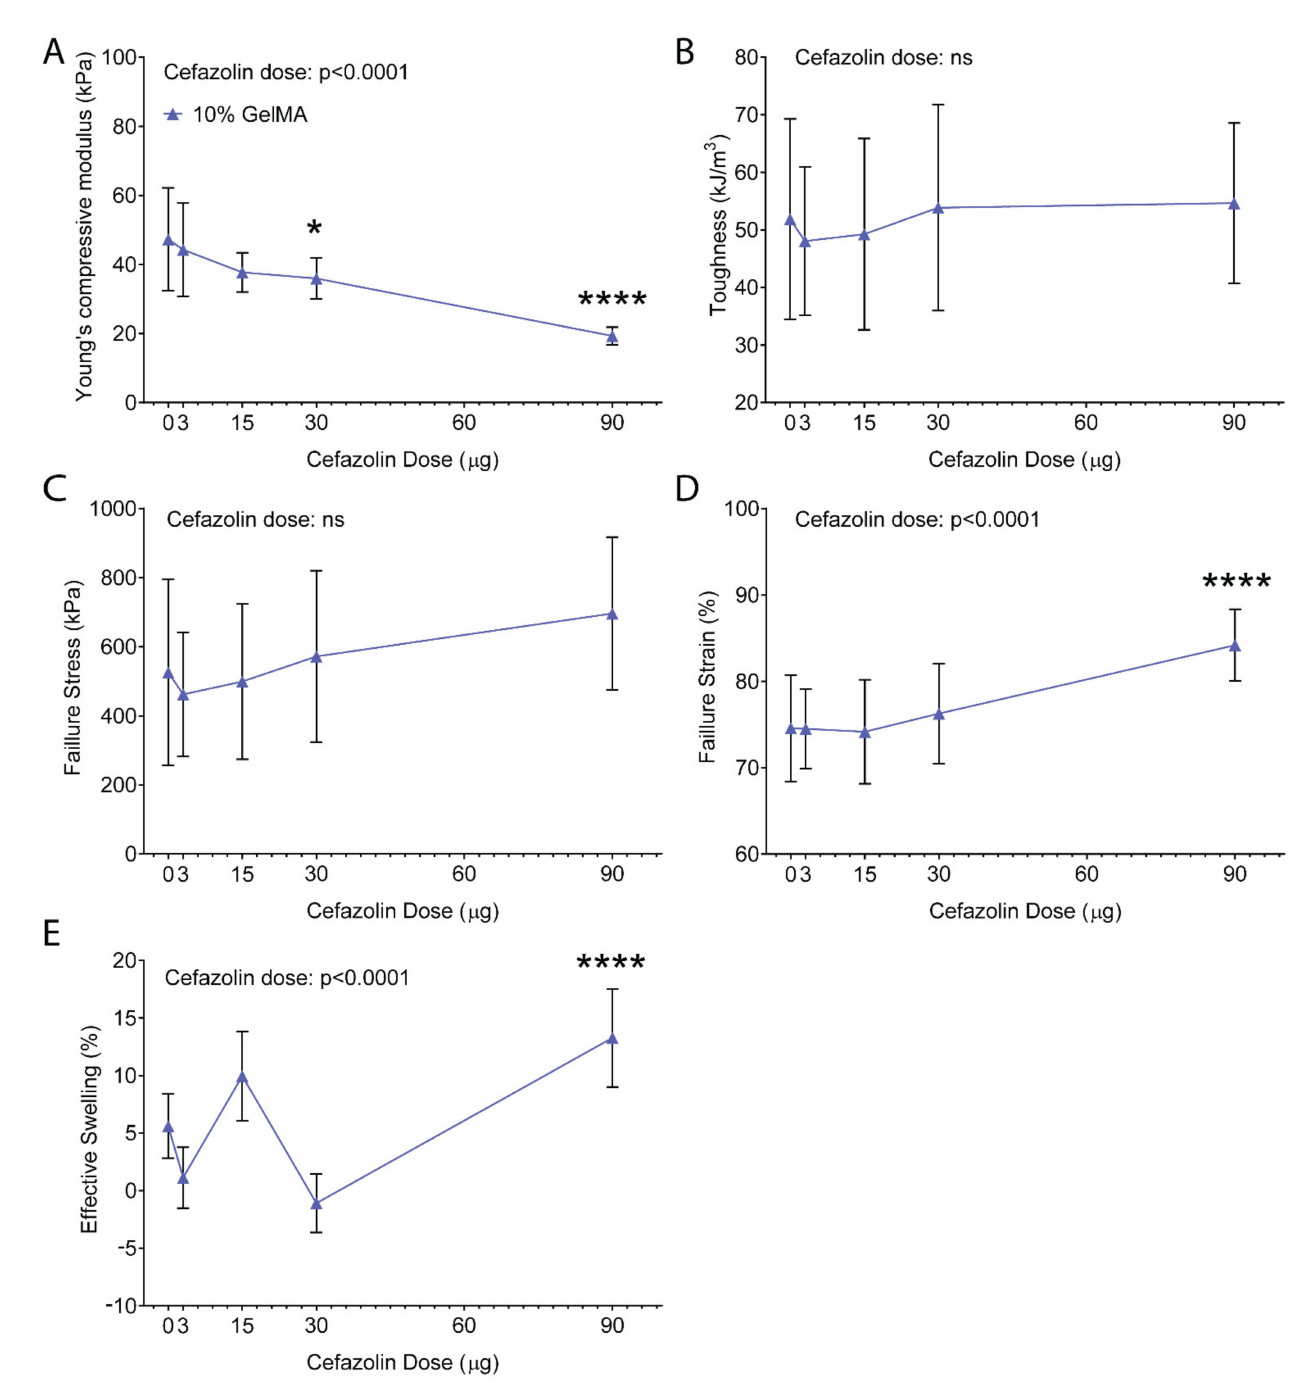
Figure 5. Compressive properties of GelMA-DDS hydrogels at 10% GelMA for cefazolin doses of 0 µ g, 3 µ g, 15 µ g, 30 µ g, and 90 µ g. ( A ) Compressive modulus. ( B ) Toughness. ( C ) Failure stress. ( D ) Failure strain. ( E ) Effective swelling. Data are shown as mean ± standard deviation, n = 8. * p < 0.05; **** p < 0.0001. All statistical significances are with reference to the control group (10%